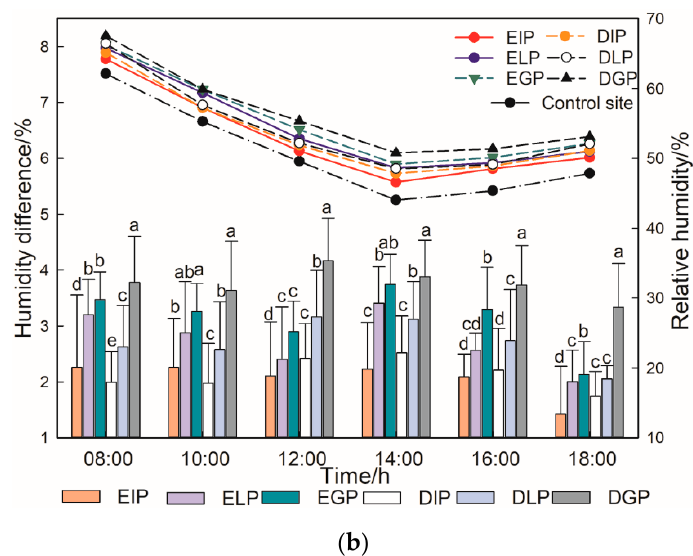
Figure 5. Meteorological parameters and microclimate regulation capabilities of evergreen tree species (ET) and deciduous tree species (DT).The significant differences between the cooling and humidifying effects of ET and DT in different configuration modes are indicated by different lowercase letters ( p < 0.05), two way ANOVA. ( a ) Daily changes in air temperature, the cooling effect of three configuration modes of evergreen and deciduous tree species at each time point. ( b ) Daily changes in relative humidity, the humidifying effect of three configuration modes of evergreen and deciduous tree species at each time point. Individual planting of evergreen (EIP); linear planting of evergreen (ELP); group planting of evergreen (EGP); individual planting of deciduous (DIP); linear planting of deciduous (DLP); group planting of deciduous (DGP). Bars represent the means ± standard errors.